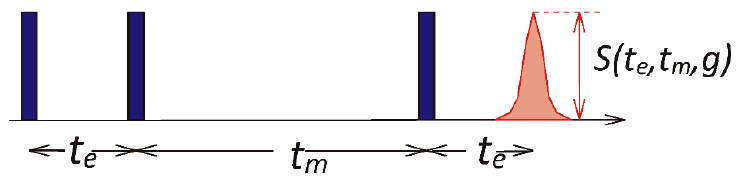
Figure 2. Stimulated echo pulse sequence featuring a mixing time t m enclosed by two evolution times t e .